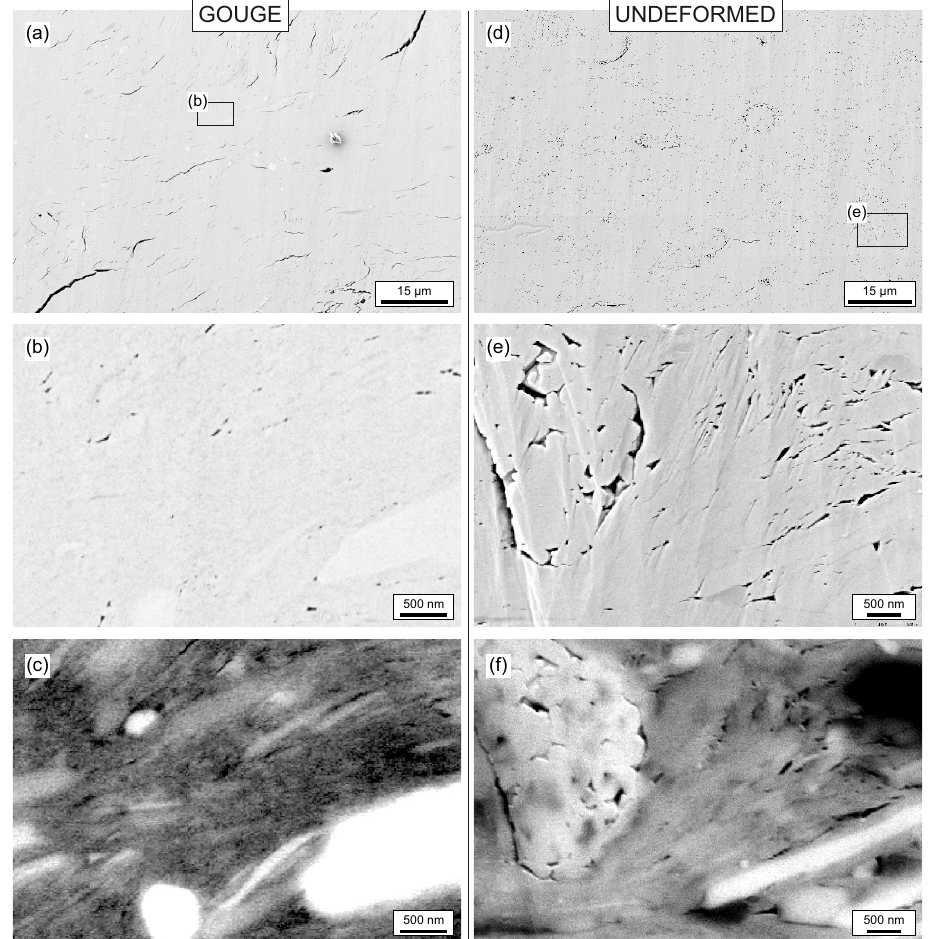
Figure 13. Comparison of the undeformed OPA (right, sample V08) to gouge porosity (left, sample V15-4). All micrographs are recorded using a BIB-SEM (SE detector). (c, f) Same location as panels (b) and (e) recorded with a BSE detector. Note the decreased visible porosity in gouge. Larger cracks in gouge are interpreted as artifacts. Bright grain to the left in panels (e) and (f) is part of a calcite